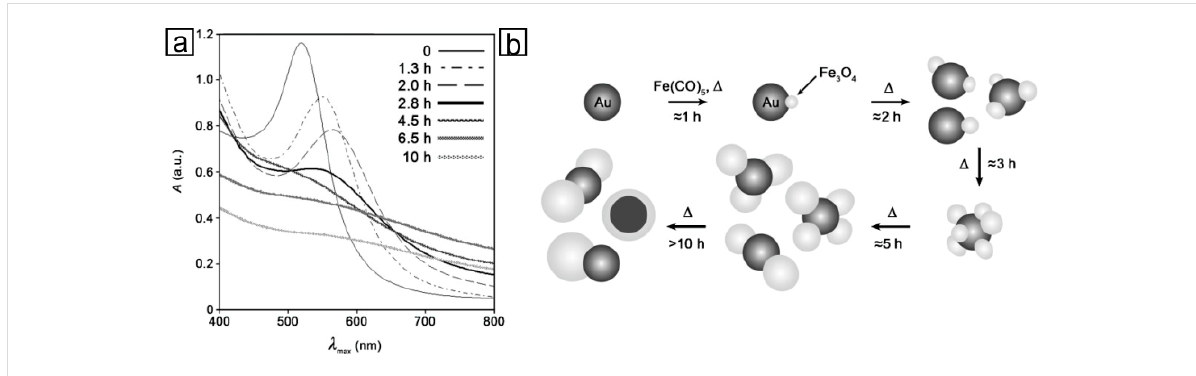
Figure 7: a) UV–vis spectra of Au@Fe 3 O 4 nanoparticles corresponding to schematic representations in b). The scheme illustrates the shape evolu- tion of the particles during heating (Au: dark gray, Fe 3 O 4 : bright gray). Reproduced with permission from [72]. Copyright 2008